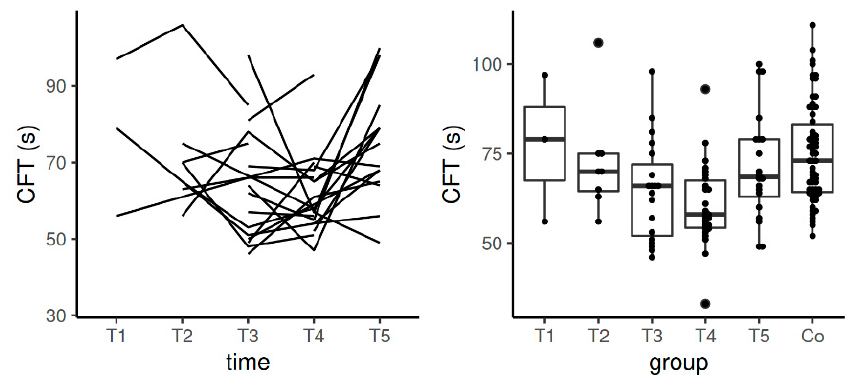
Figure 6. Spaghetti plot of the data from the longitudinal study (left), and swarmplot with boxplot of the same data together with the data from the control group (right)—the results of CFT in